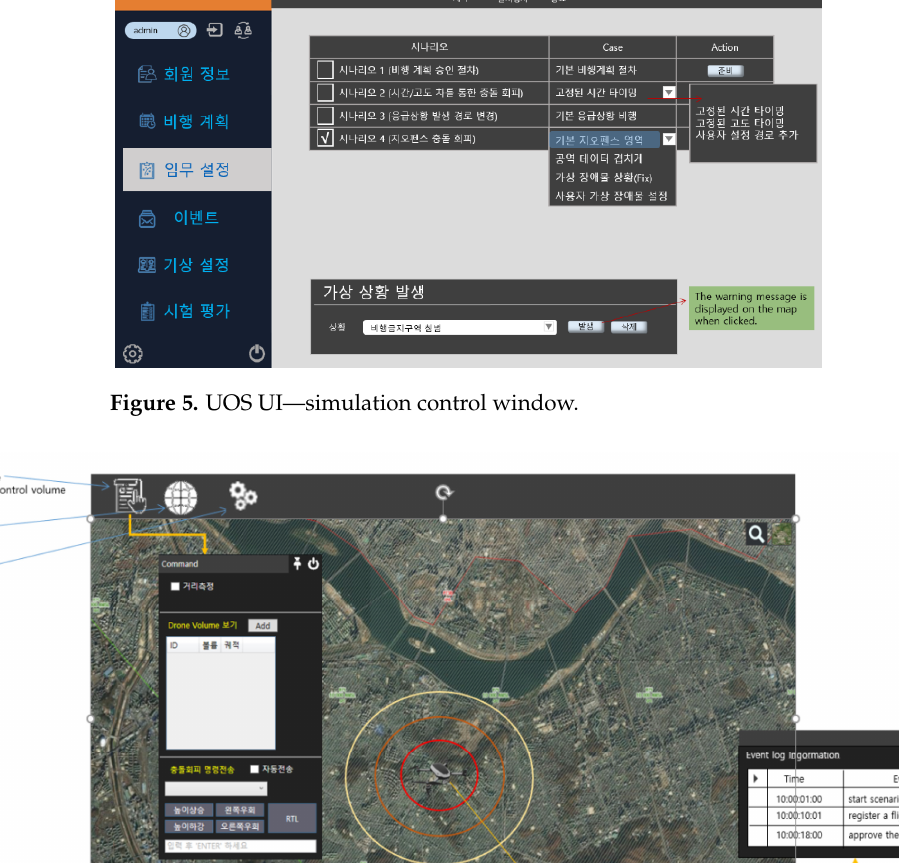
Figure 4. UOS (UTM Operating System) UI—registration window of a flight plan.